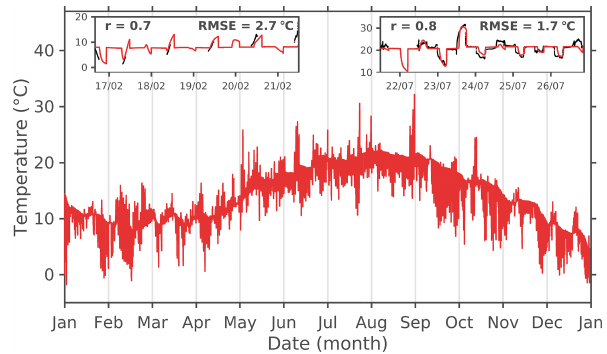
Figure 4. Measured (black points) and simulated (red lines) mud surface temperature in 2008. r is the Pearson’s correlation coeffi- cient. RMSE is the root mean square error ( ◦